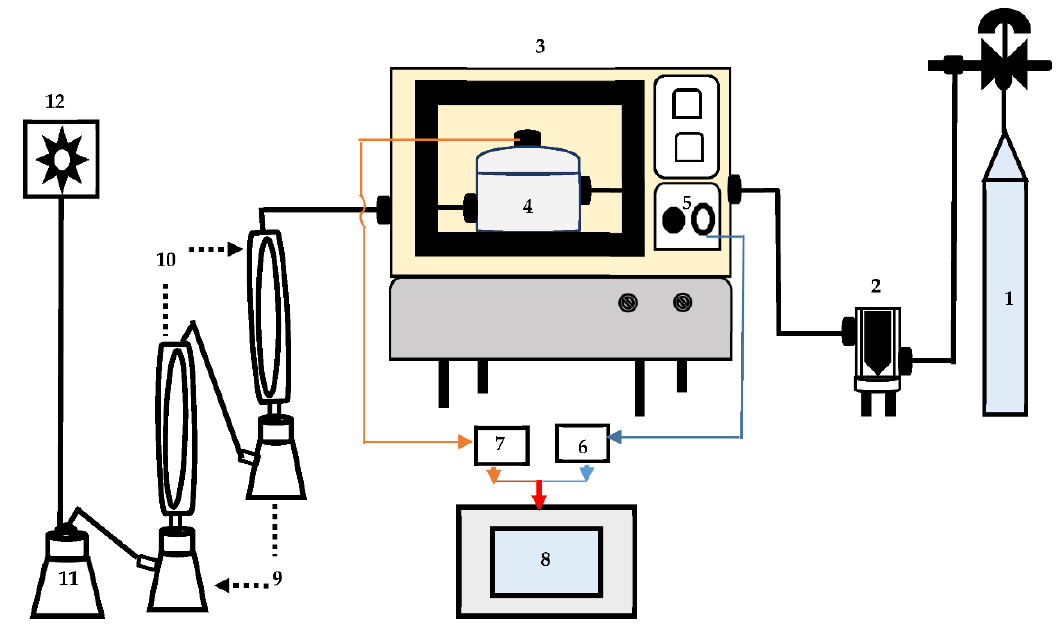
Figure 2. Schematic diagram of the microwave torrefaction. (1) Nitrogen gas tank; (2) gas meter; (3) microwave oven; (4) quartz reactor; (5) microwave control panel; (6) power logger; (7) temperature transmitter; (8) recording computer; (9) torrefaction liquor collector; (10) gas condensers; (11) smoke trap; (12) exhaust fan.